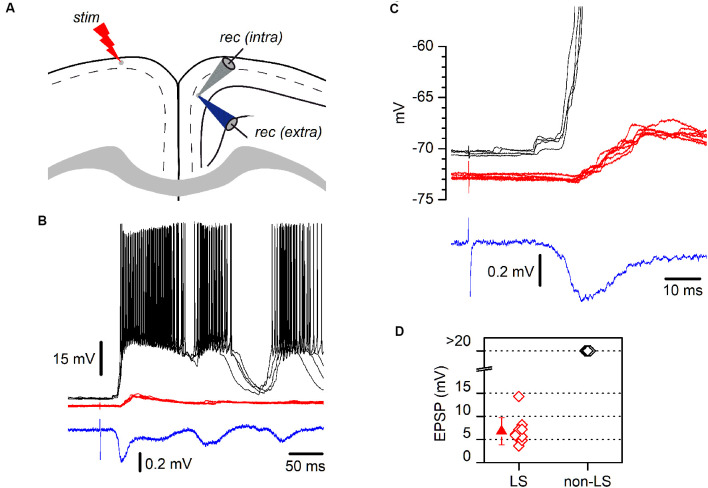
LS and non-LS pyramidal neurons respond differently to incoming epileptiform discharges. (A) The diagram of a coronal GRSC slice showing the positions of recording and stimulating electrodes. The extracellular recording electrode (blue electrode) was kept in the same position while successive neurons were recorded intracellularly (gray electrode); electrical stimuli were applied to the contralateral side (“stim”). (B) Responses of a non-LS (black traces) and an LS pyramidal neuron (red traces) during the propagation of epileptiform discharges (blue trace: extracellular recordings) evoked by contralateral stimulation. Both neurons were recorded sequentially and their somata were placed close together. Each panel features five consecutive superimposed traces. The extracellular recording was the average of five consecutive responses. (C) The initial section of the responses shown in panel B presented on larger time and voltage scales; note the delayed onset and smaller amplitude of the response recorded in the LS neuron (red traces). (D) The peak amplitude of the EPSPs recorded during the propagation of epileptiform discharges: LS neurons, red symbols; non-LS neurons, black symbols. When the response was supra-threshold, we assigned an amplitude of >20 mV.